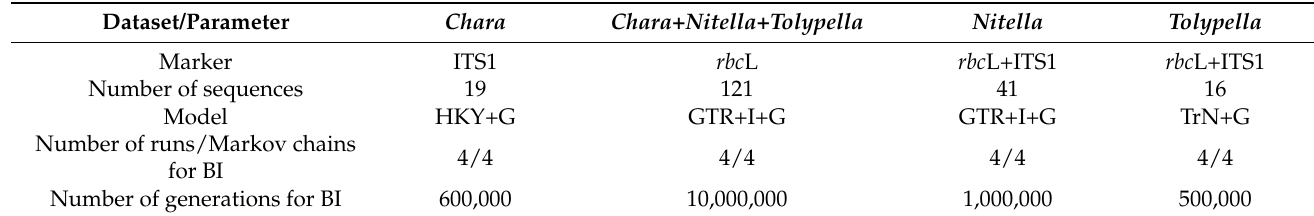
Table 3. Datasets’